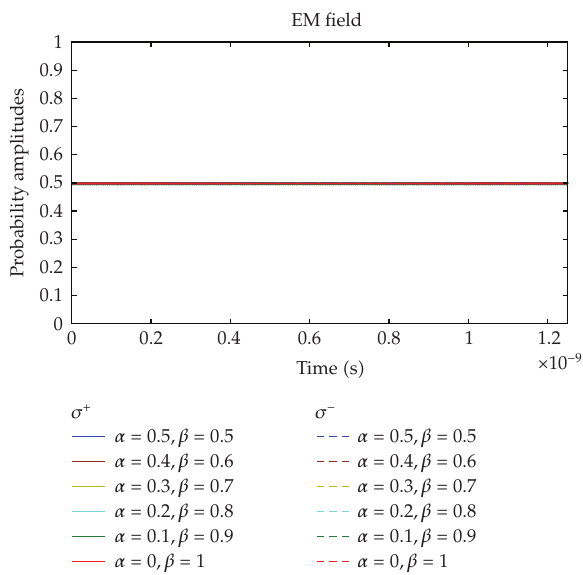
Figure 12: Right and left circular polarization prob. amplitudes for large Δ